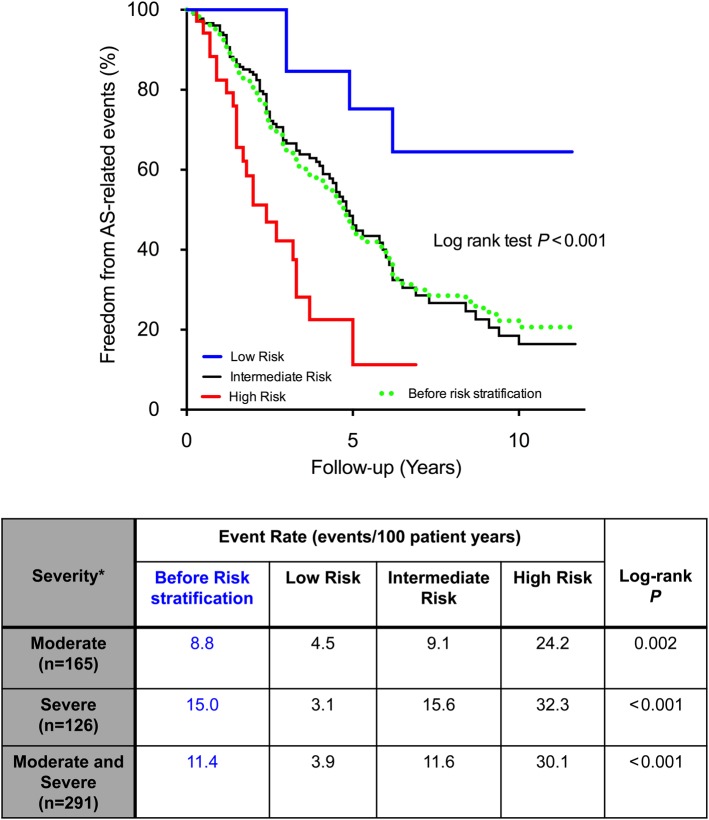
Improvement in risk stratification using the clinical score in patients with moderate
and severe aortic stenosis. Compared with the natural history of patients with
moderate/severe aortic stenosis (green dotted line), the clinical risk score
demonstrated significant improvement in identifying patients at low and high risk for
adverse events. Furthermore, patients at intermediate risk had an event rate very
similar to that prior to risk stratification. This supported the incremental role of
the clinical score over the traditional assessment of aortic stenosis severity.